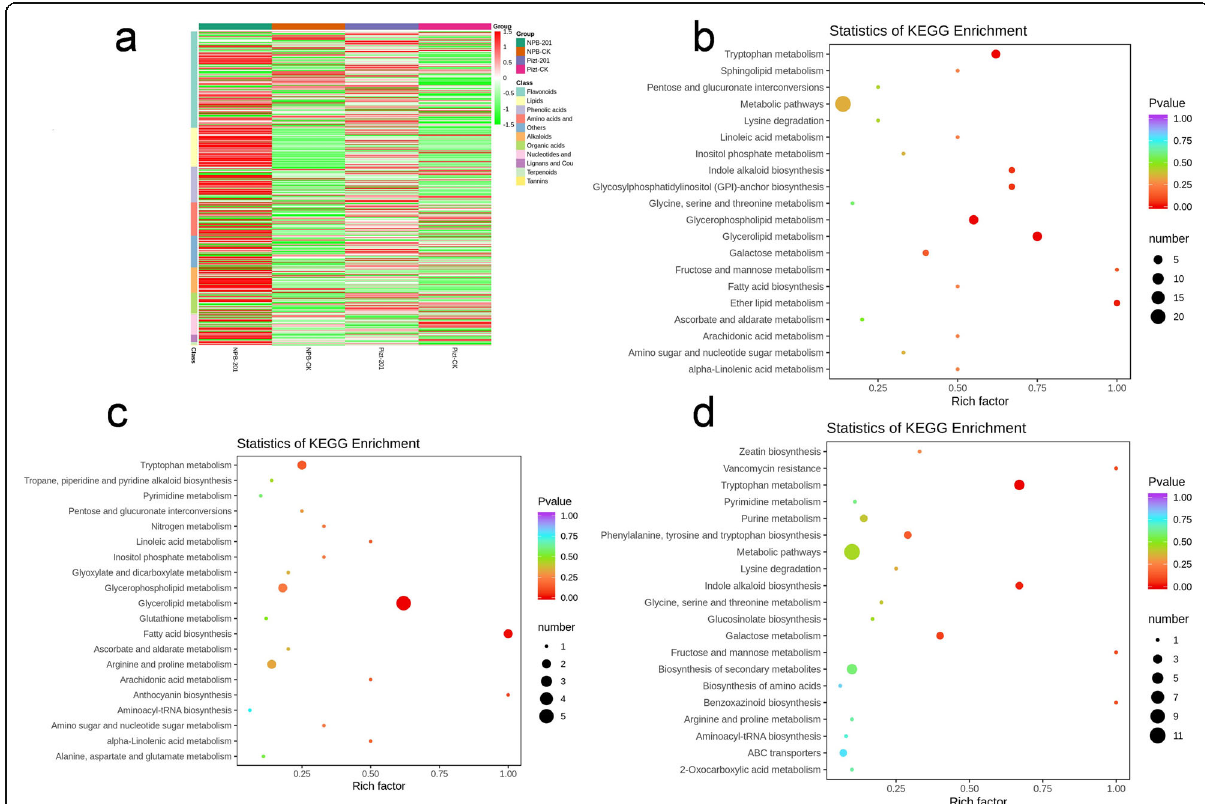
Fig. 6 Clustering and KEGG analysis of the defferentially expressed metabolisms between Piz-t-KJ201, NPB-KJ201, and their mock treated. a Heatmap showing the relative abundance of functional categories of the four groups. b,c,d KEGG enrichment of differentially abundance metabolisms specific to comparison NPB-KJ201/NPB-Mock, Piz-t-KJ201/Pizt-Mock, and Piz-t-KJ201/NPB-KJ201, respectively. The Rich factor is the ratio of differentially expressed metabolites numbers annotated in this pathway term to all metabolites numbers annotated in this pathway